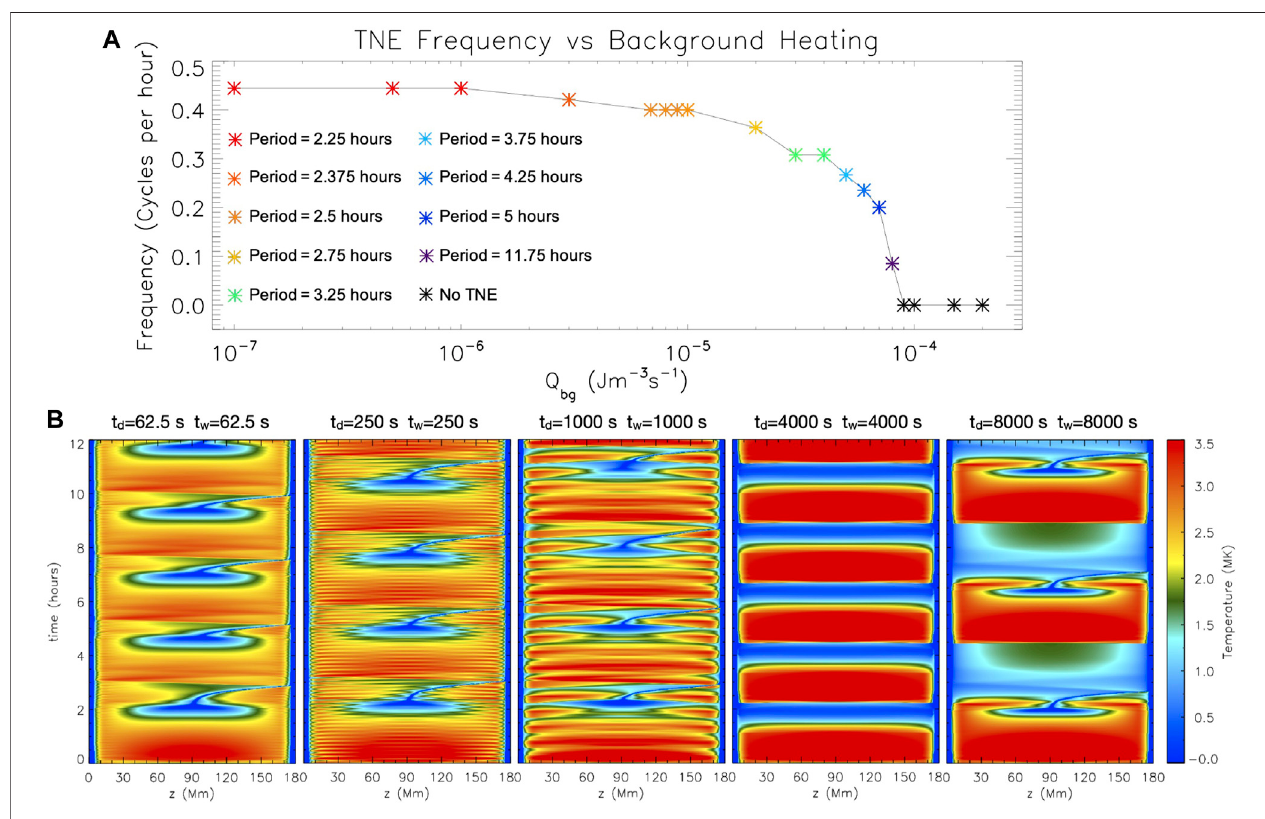
FIGURE3|(A) FrequencyoftheTNEcycleforone-dimensionalsimulationsofa180 Mmlongloopwithfootpointheating(locatedataheightof12.5 Mm)forwhich the heating events last a time of t d = 125 s and with a waiting timeof t w = 125 s between events but with a varying value ofthe background heating term (constant along the loop). (B) 5-layer panel: time-distance diagrams of the temperature variation along the loop for one-dimensional simulations ofthe same loop but with varying values of t d and t w . For further details please see Johnston et al. (2019) (adapted from Figures 6, 10 of that paper, reproduced with permission ©